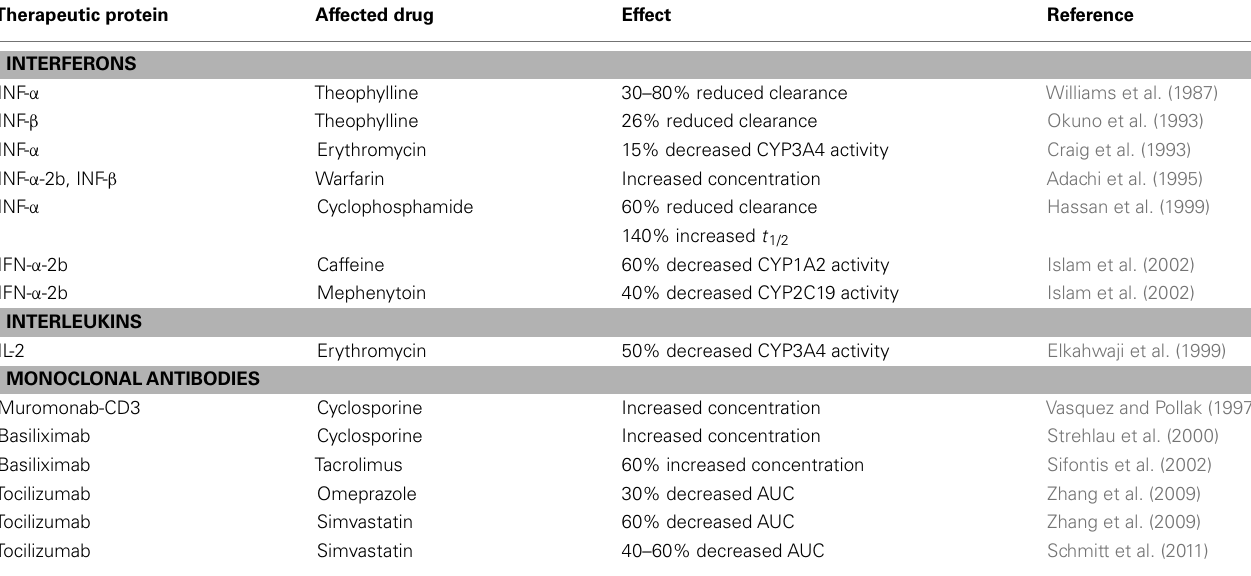
Table 2 | Examples of drug interactions caused by therapeutic